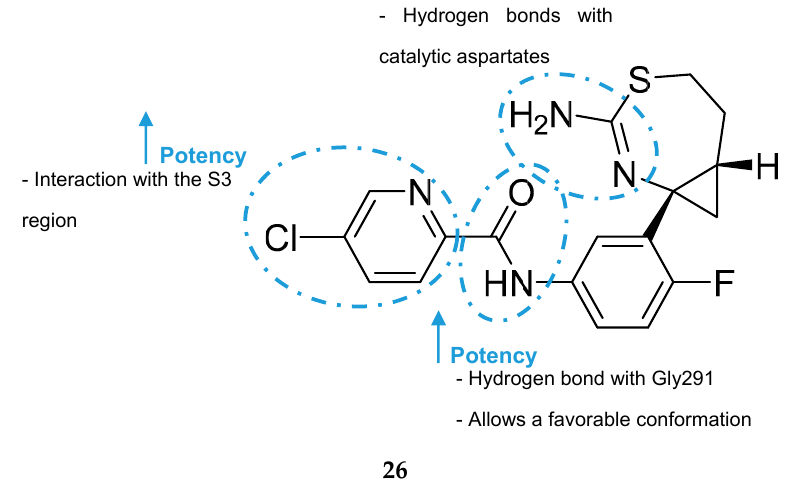
Figure 24. SAR of optimized inhibitor 26 developed by Roche.